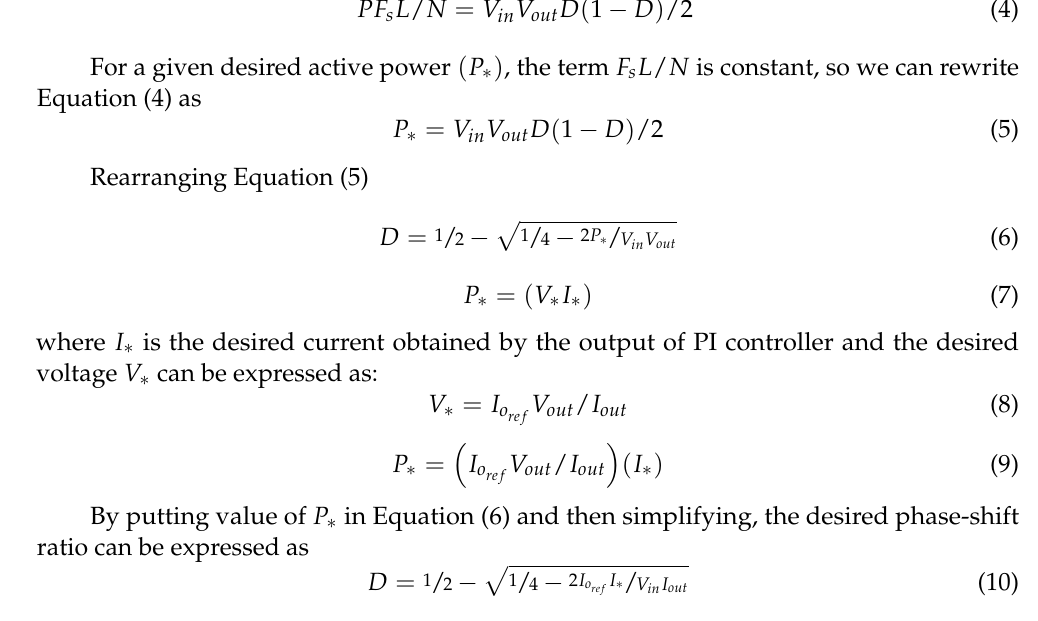
Figure 7. Average model of DAB–DC/DC converter.